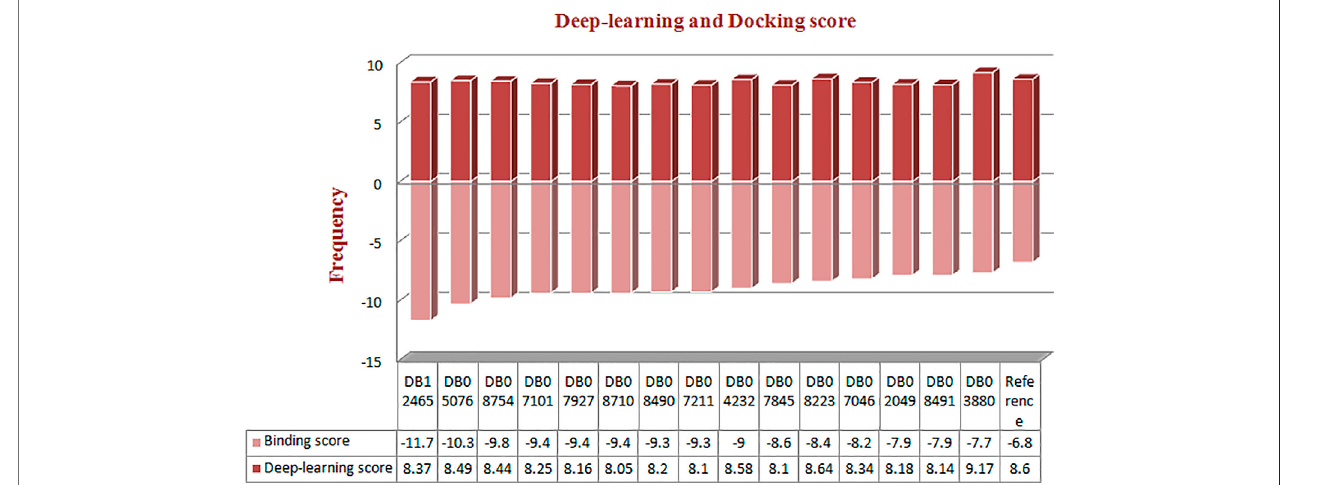
FIGURE 3 | Frequency distribution graph of docked compounds over the range of deep learning and docking